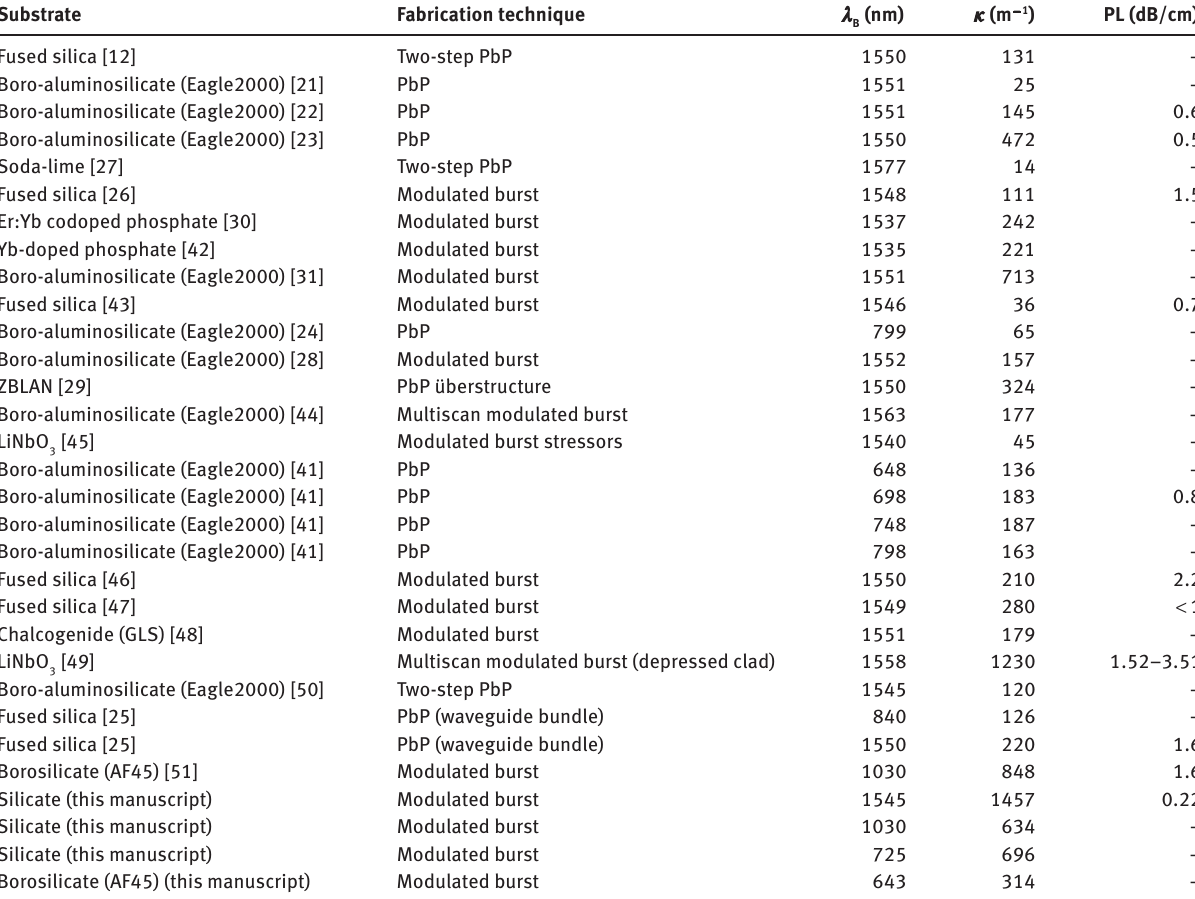
Table 1: Coupling coefficient κ and PL of WBGs fabricated by different research groups using the ULI technique. For comparison, the